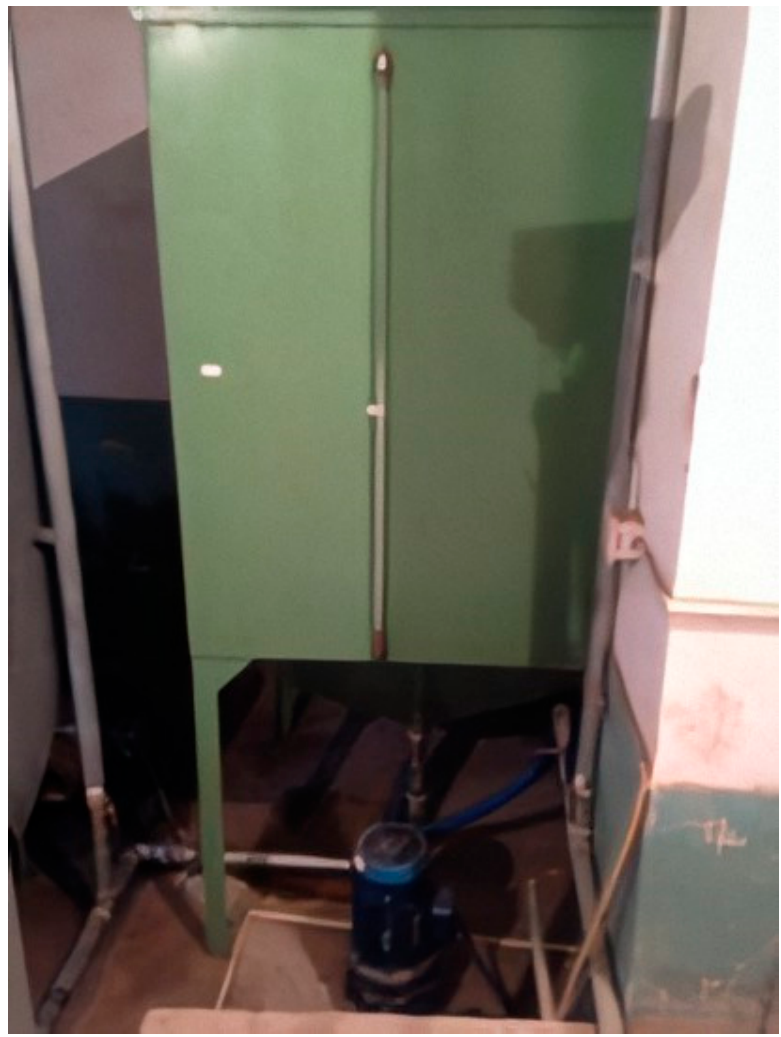
Figure 3. Muddy water tank.